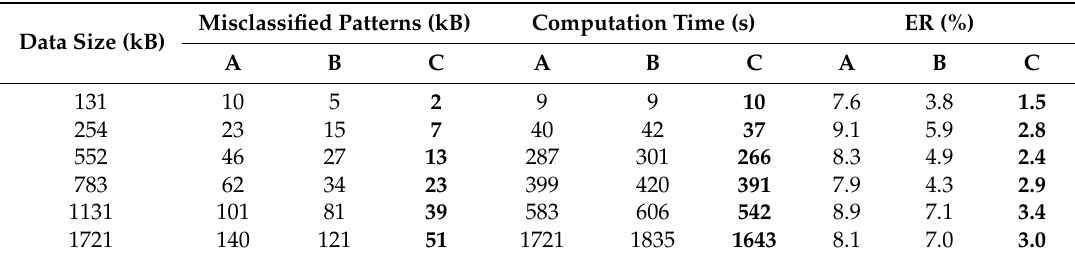
Table 4. Comparisons of misclassified patterns, computation time and the error rate (ER) for different sizes of data sets for buried sensors. A: K-means; B: FCM; C: